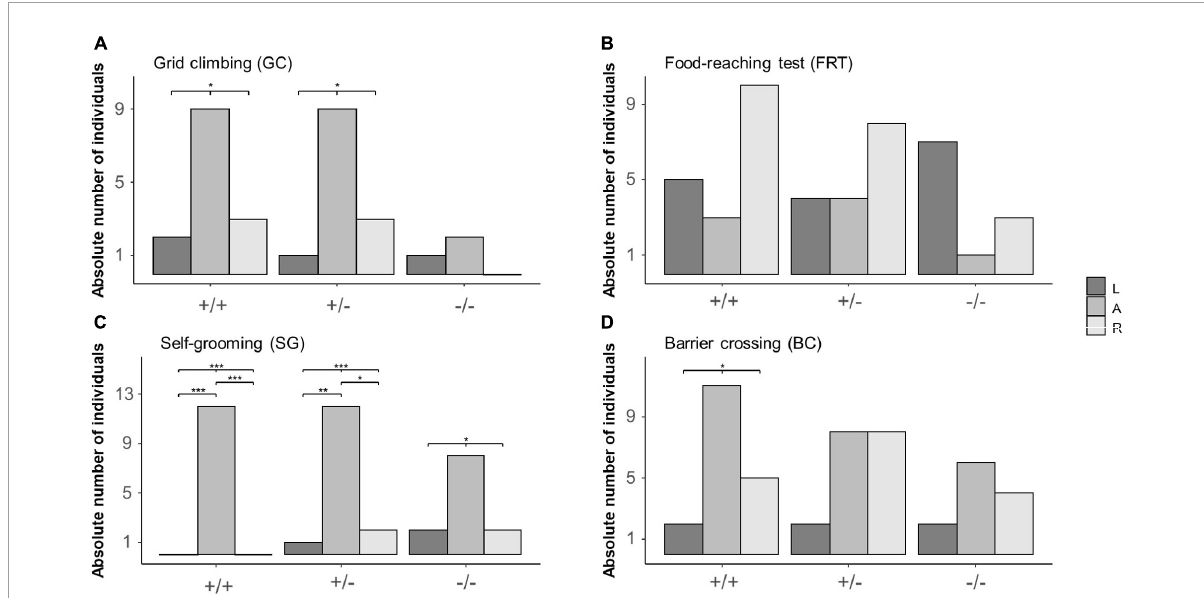
FIGURE3 Distribution of left pawed, ambilateral and right pawed mice from three different 5-HTT genotypes across four different behaviors. Lateralized behavior of mice was observed during four different behaviors: (A) grid climbing (GC), (B) food-reaching (FRT), (C) self-grooming (SG), and (D) barrier crossing (BC). Based on individually calculated Z-scores, mice were categorized into being either left pawed, ambilateral or right pawed. Data are presented as absolute count frequencies. * P ≤ 0.05; ** P ≤ 0.01; *** P ≤ 0.001. Significant results of chi 2 - and post hoc binomial tests are shown